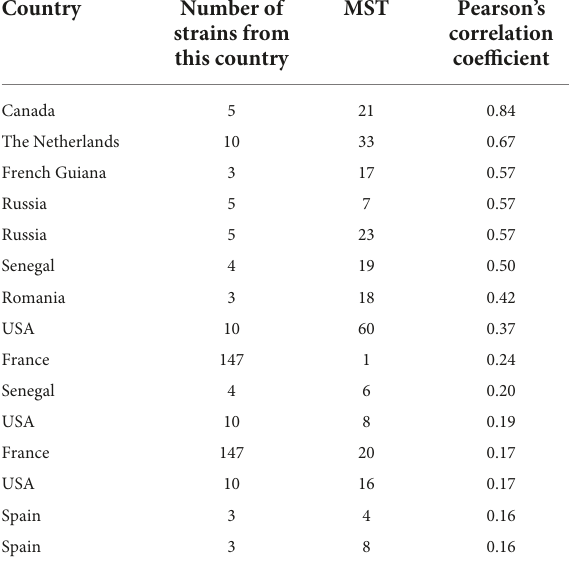
TABLE 5 Associations of multispacer sequence typing (MST) and countries. Country Number of MST Pearson’s strains from correlation this country coefficient